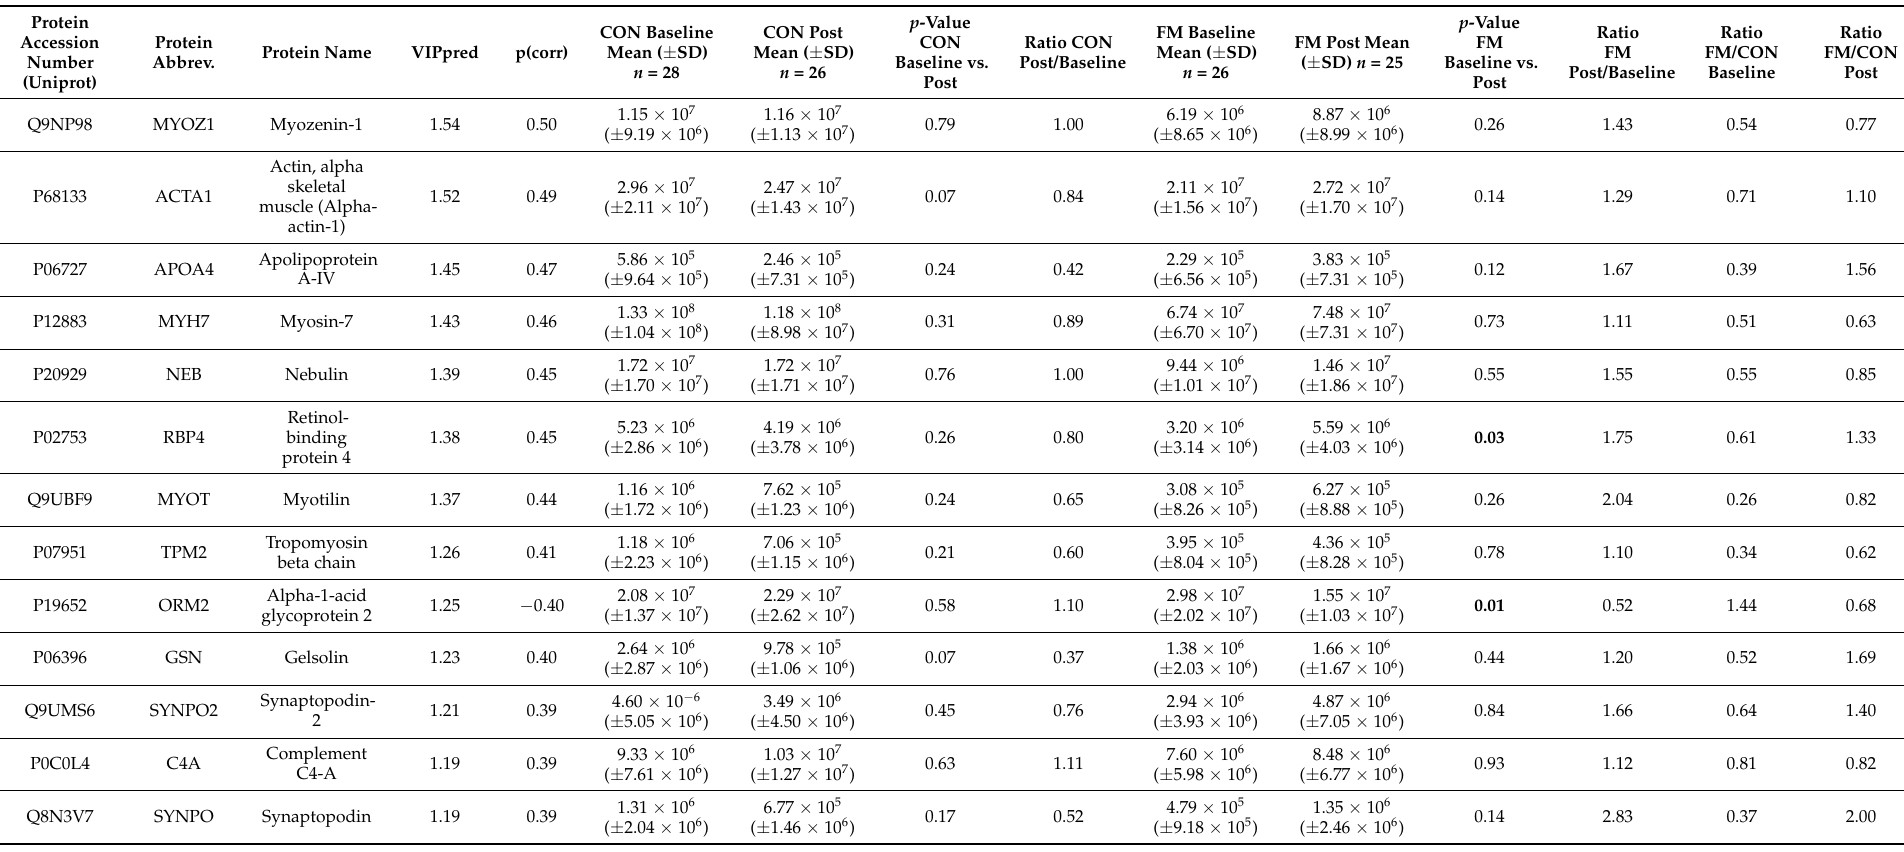
Table 3. Summary of the Uniprot accession number protein name, VIP predictive, p(corr), mean value and standard deviation ( ± SD) of protein intensity, p -value (within groups), the ratio within and between groups before and after 15-week exercise intervention exercise. The accession numbers are according to the UniProt database. The proteins correspond to visualized proteins in the loading plot of Figure 2 and are sorted depending on their VIPpred value. The higher VIPpred, the more important regressor for the model. p(corr) is the multivariate correlation coefficient of each variable (protein) for the model. Protein abbreviation (protein abbrev.) corresponds to significant proteins from loading plot Figure 2. Significant proteins within groups are marked in